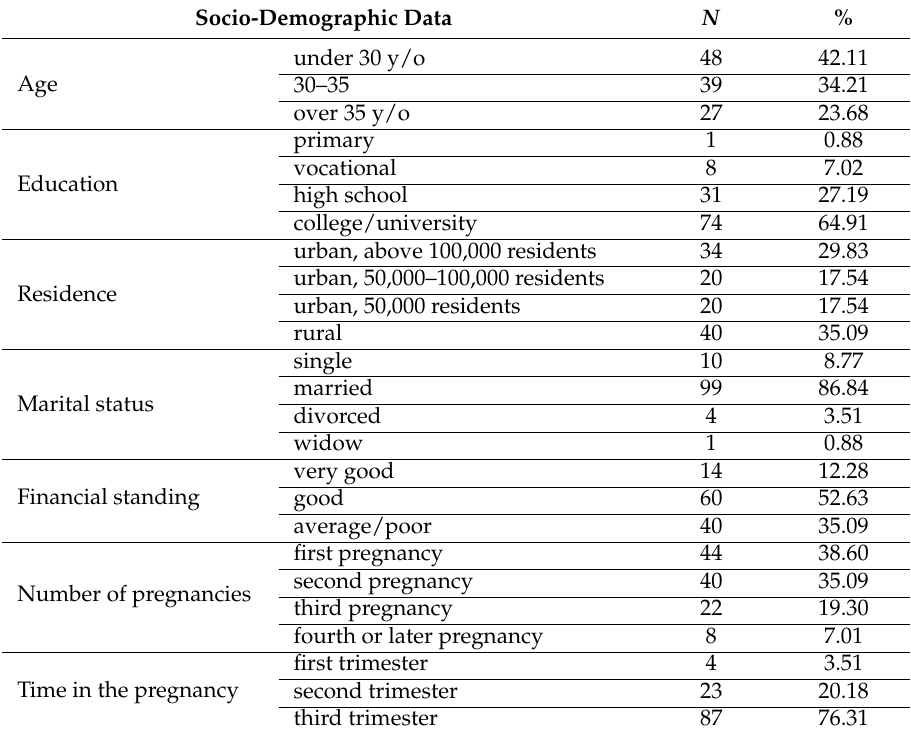
Table 1. Participants’ characteristics.